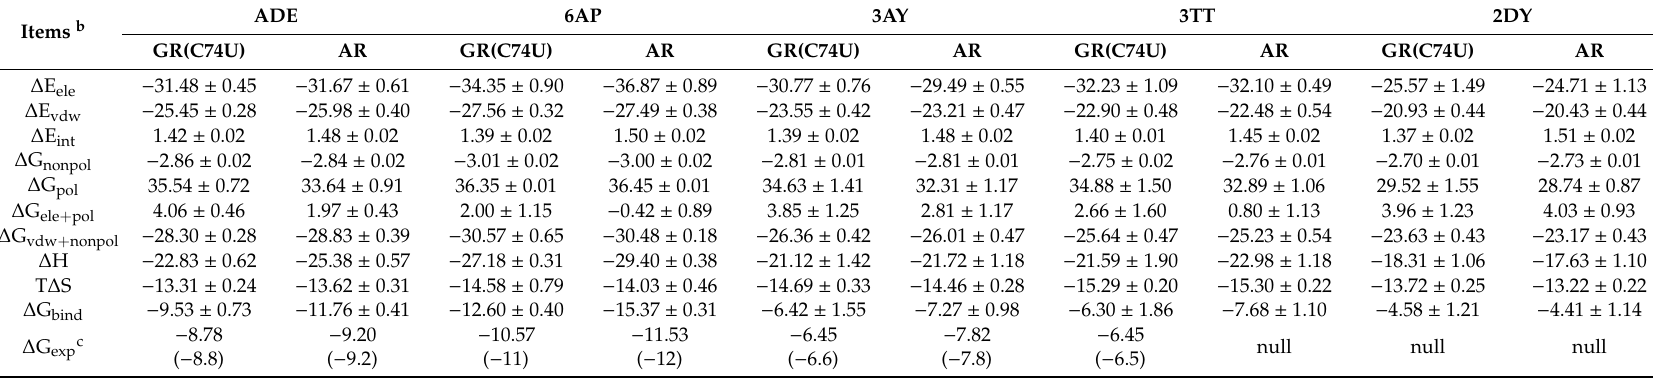
a The unit is kcal / mol. Standard errors denoted with ± signs were calculated by σ = standard deviation / N 1 / 2, where N is 10 for the 10 independent molecular dynamics (MD) simulations for each complex. b The symbols of the energy terms are the same as in the section of the binding free energy calculations. c The experimental values are from References [16,26] calculated from ∆ G exp = − RT lnK d ; the values from the references are shown in round